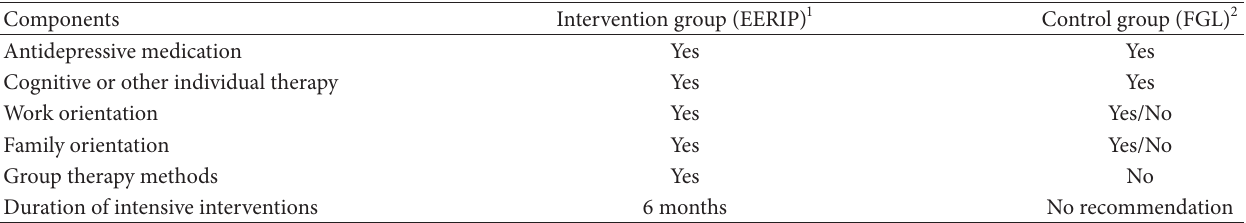
Table 1: Recommendations in the early eclectic rehabilitative intervention program versus the finnish guidelines for managing depression: early eclectic rehabilitative intervention program versus the finnish